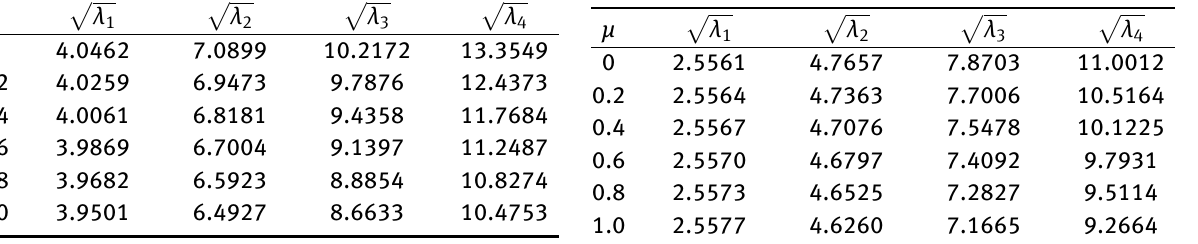
Table 11: Frequency parameter for CS case for different nonlocal parameter